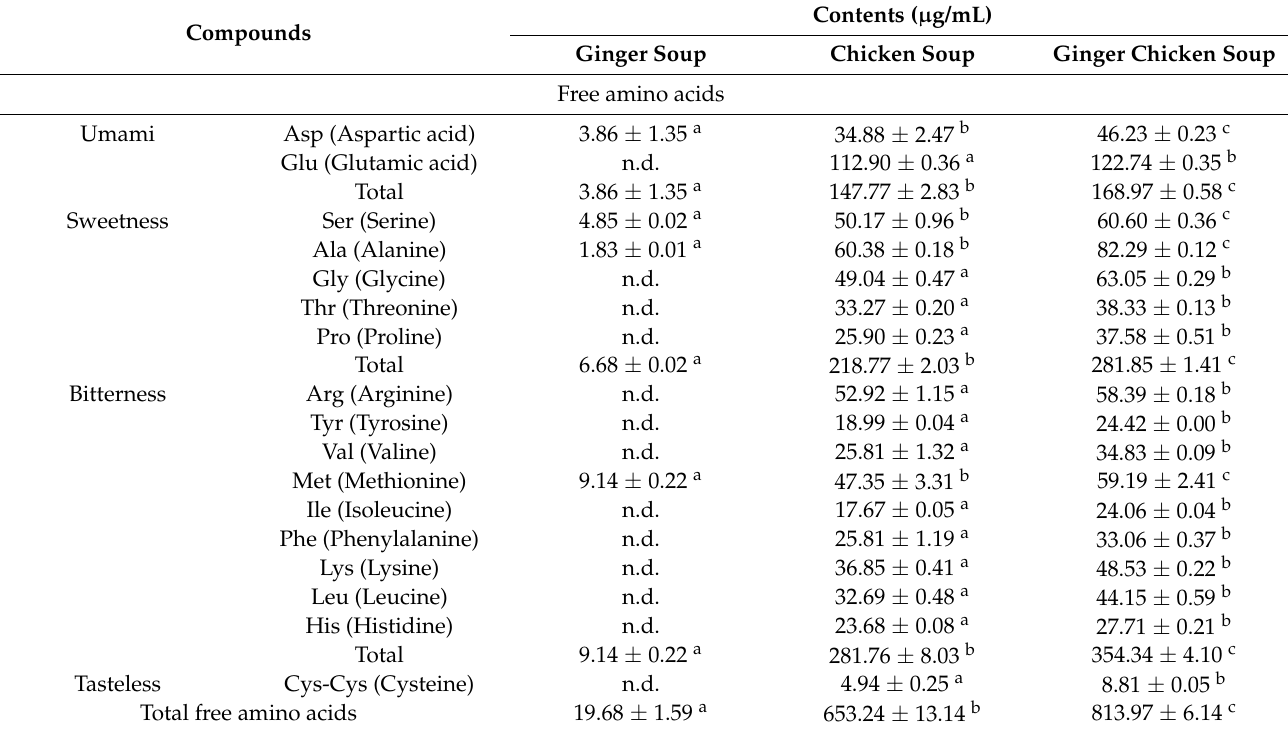
Table 2. The content of free amino acids, 5 (cid:48) -nucleotides, and organic acids in different soups.